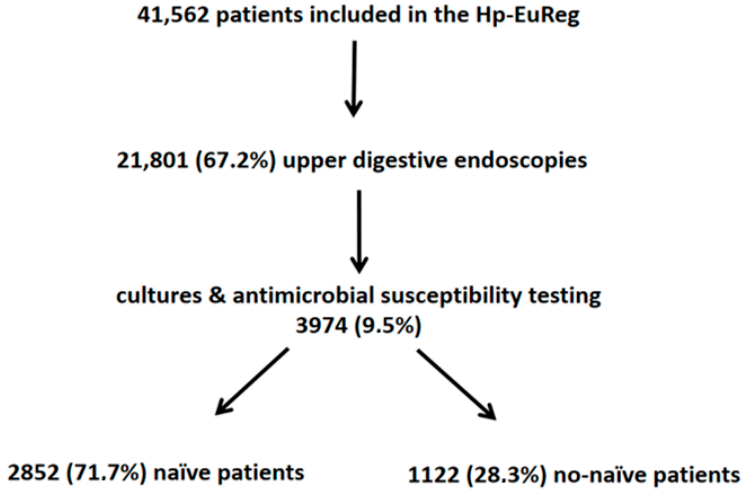
Figure 1. Flow chart of patients included in the study.